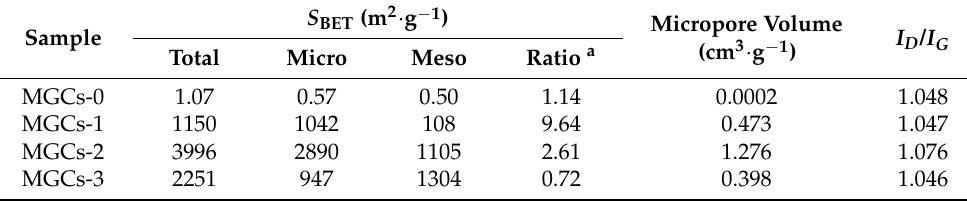
Table 1. Microstructure of MGCs determined by nitrogen sorption isotherms and Raman spectra.